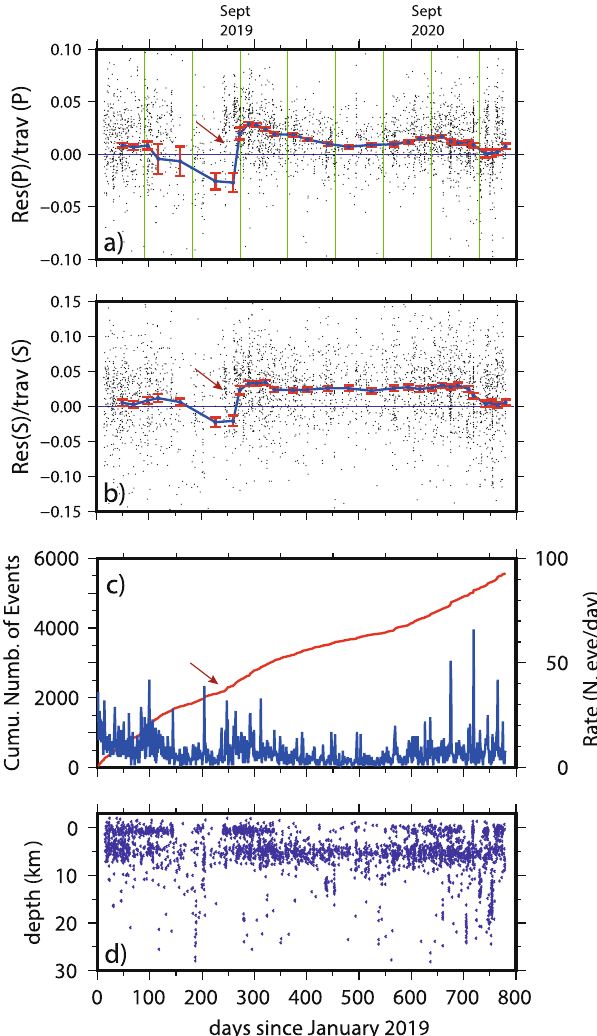
Fig. 2 Time evolution of seismicity and velocity residuals since January 2019. P-wave ( a ) and S-wave ( b ) residuals after location in the 3D model vs time. The mean residuals of each event, normalized by the traveltime to account for different ray path-lengths, are smoothed by a moving average of 200 points (events) shifted forward by 100 points. The average values (red points) are associated to the right end of the window, determining an apparent visual shift of the mobile mean. Red vertical bars are the standard deviation of the mean. Green lines mark a 3 months period. ( c ) Seismicity rate and Energy vs time, ( d ) hypocentral depth vs time. Note the large P and S positive residuals after mid-September 2019 highlighting a change in the volcano structure (red arrow). This change occurred after a deep seismicity cluster and in concomitance with a sharp increase of seismicity. Note the further and more recent increase in seismicity, both deep and shallow clusters, started in December